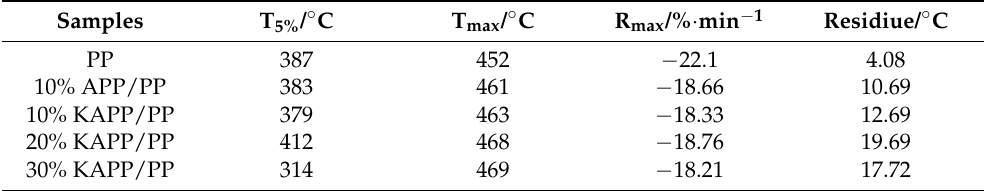
Figure 12. TGA ( a ) and DTG ( b ) curves for flame retardant PP. Table 8. Thermal weight loss data for flame retardant PP under nitrogen